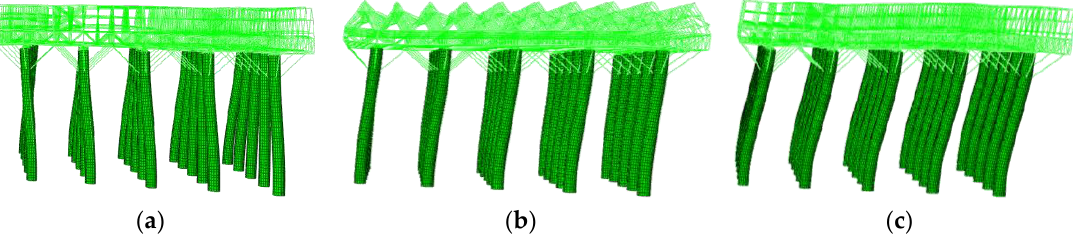
Figure 14. Vibration mode shapes: ( a ) First mode (torsional vibration); ( b ) Second mode (vibration direction is perpendicular to the A-shaped frame direction); ( c ) Third mode (vibration direction is along the A-shaped frame direction).